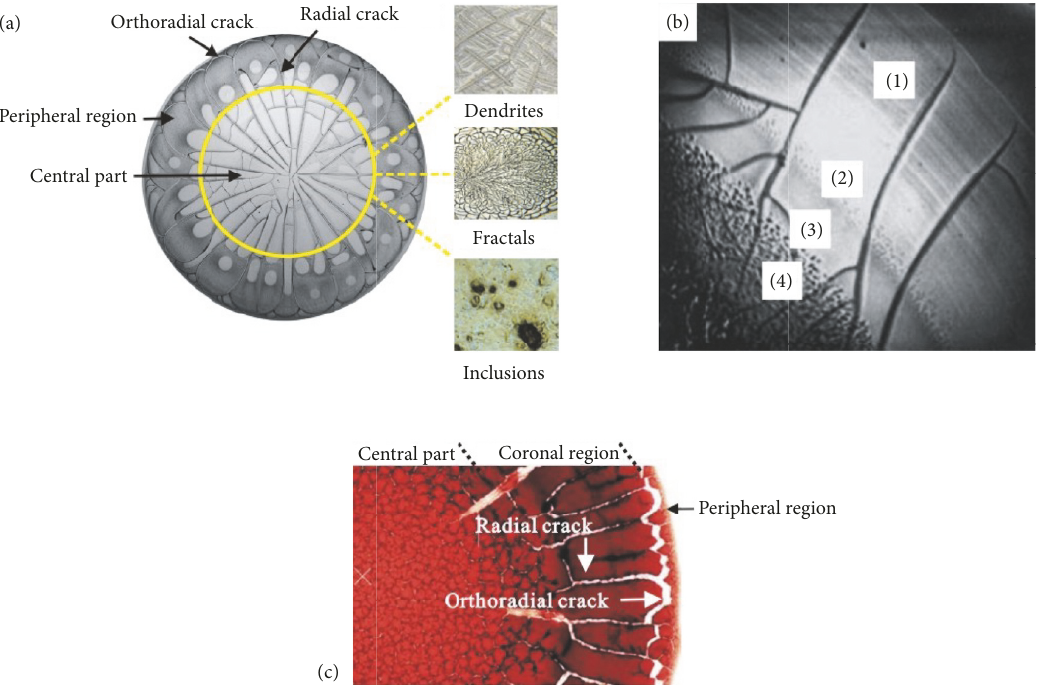
Figure 8: Desiccation patterns in the sessile drop of (a) blood plasma from a healthy adult (adopted from [61] with the permission of Springer and from [62] with the permission of Hindawi); (b) morphological details of four regional patterns in the sessile drop of BSA saline solution: (1) homogeneous protein film, (2) protein precipitates, (3) protein gel, and (4) salt crystal [63] (reproduced with permission of Elsevier); (c) whole blood droplet drying on a glass substrate (adopted from [64] with the permission of Cambridge University Press). The whole figure is reproduced from